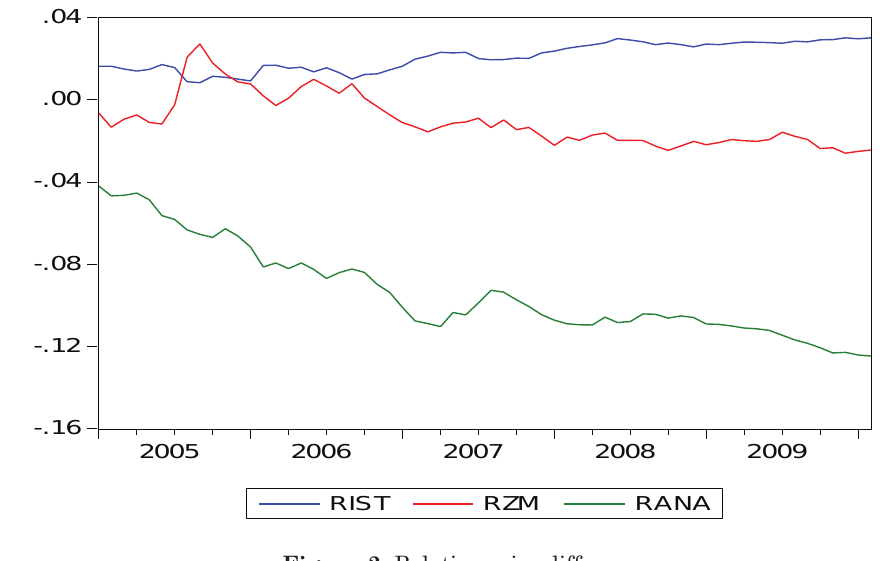
Figure 2. relative price